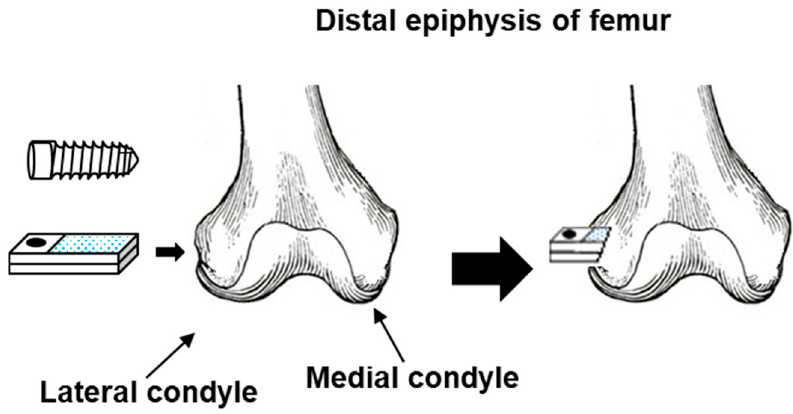
Figure 1. Schematic illustration of method of implantation into femur of rabbits.